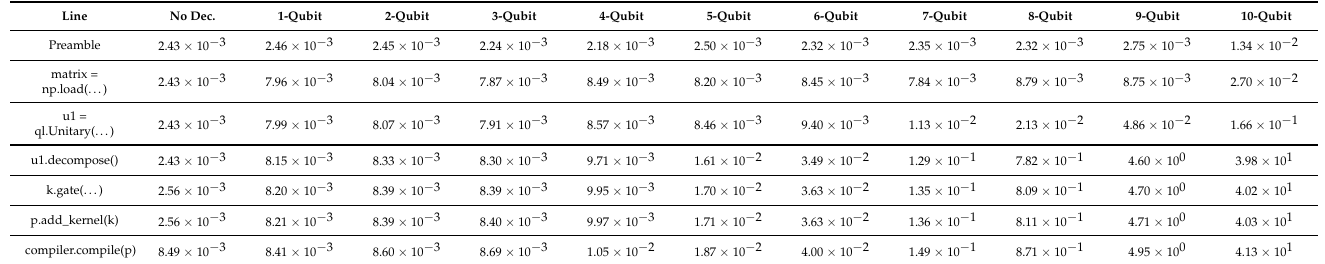
Table 2. Total execution time at each line of Listing 1 for the decomposition of matrices of different sizes, in